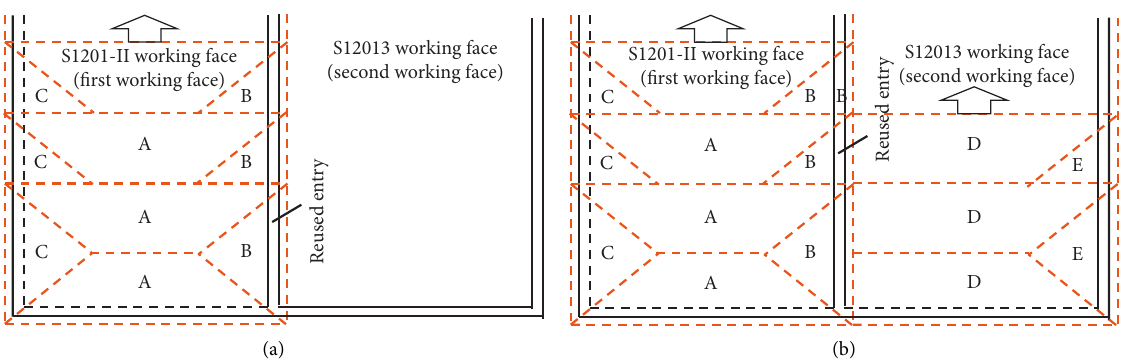
Figure 3: Plan view of the roof structure: (a) the first working face and (b) the second working